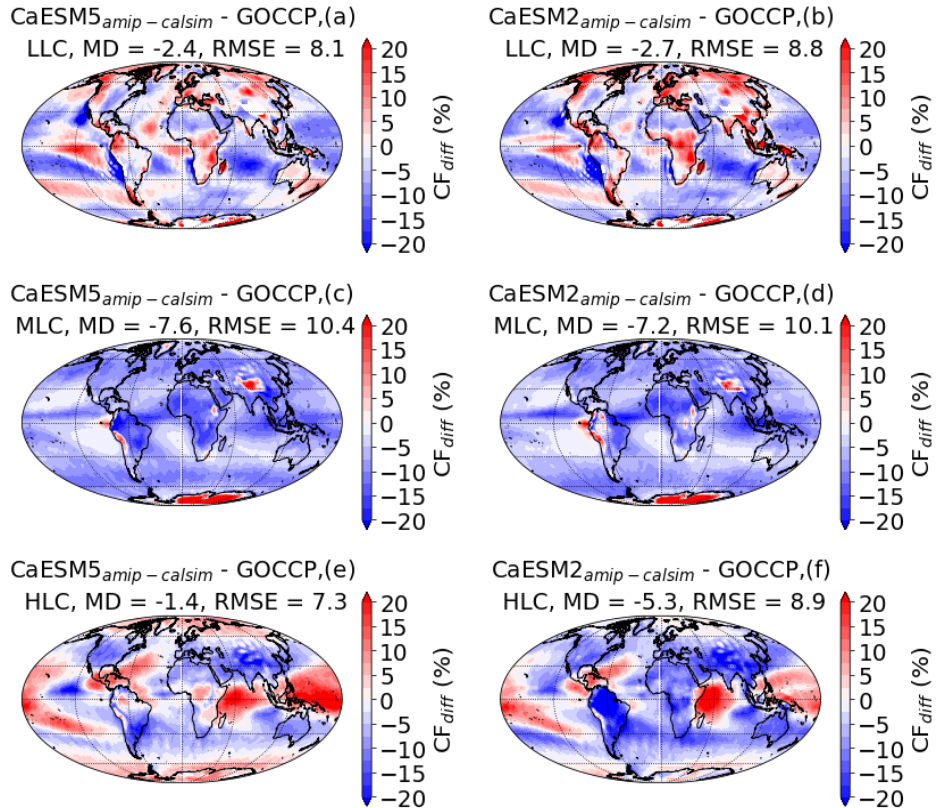
Figure 5. The model bias in annually averaged global distribution of CF for low-level cloud (LLC) ( a , b ), mid-level cloud (MLC) ( c , d ), and high-level cloud (HLC) ( e , f ).